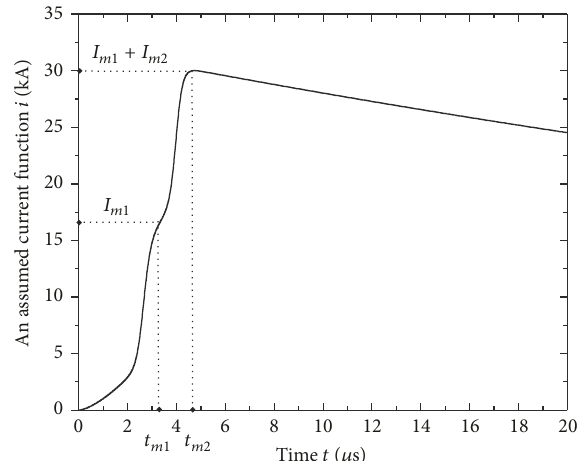
Figure 1: An assumed two-peaked current waveshape from [27] given by (3).